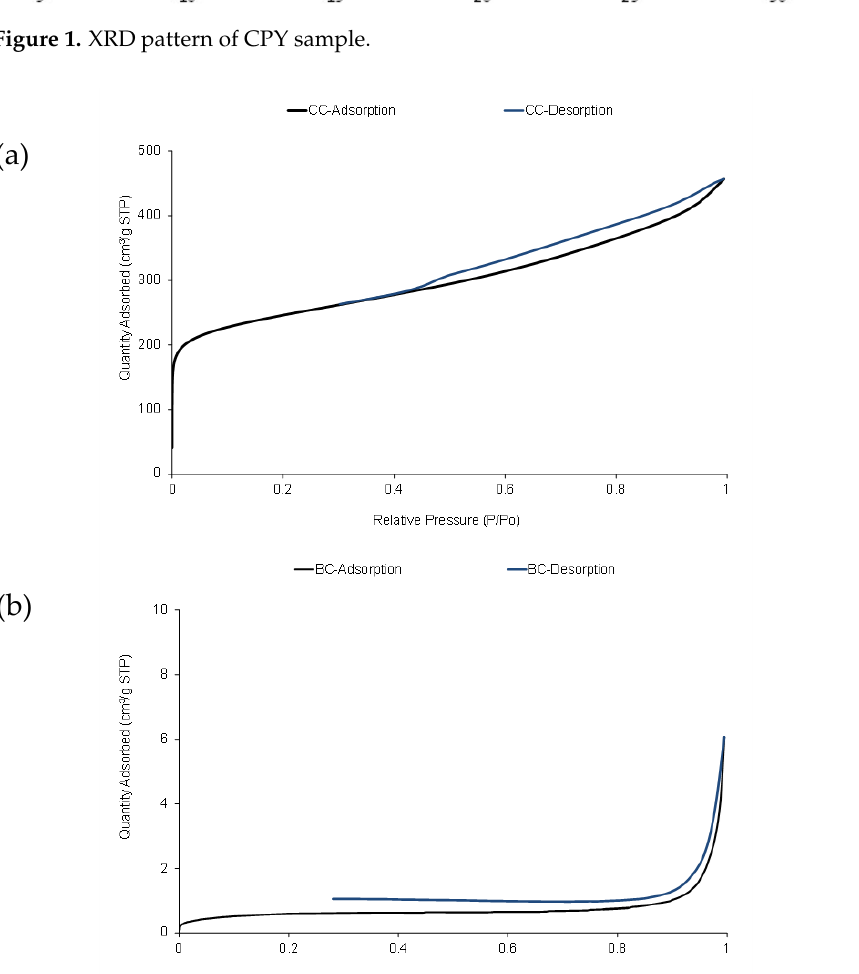
Figure 1. XRD pattern of CPY sample .